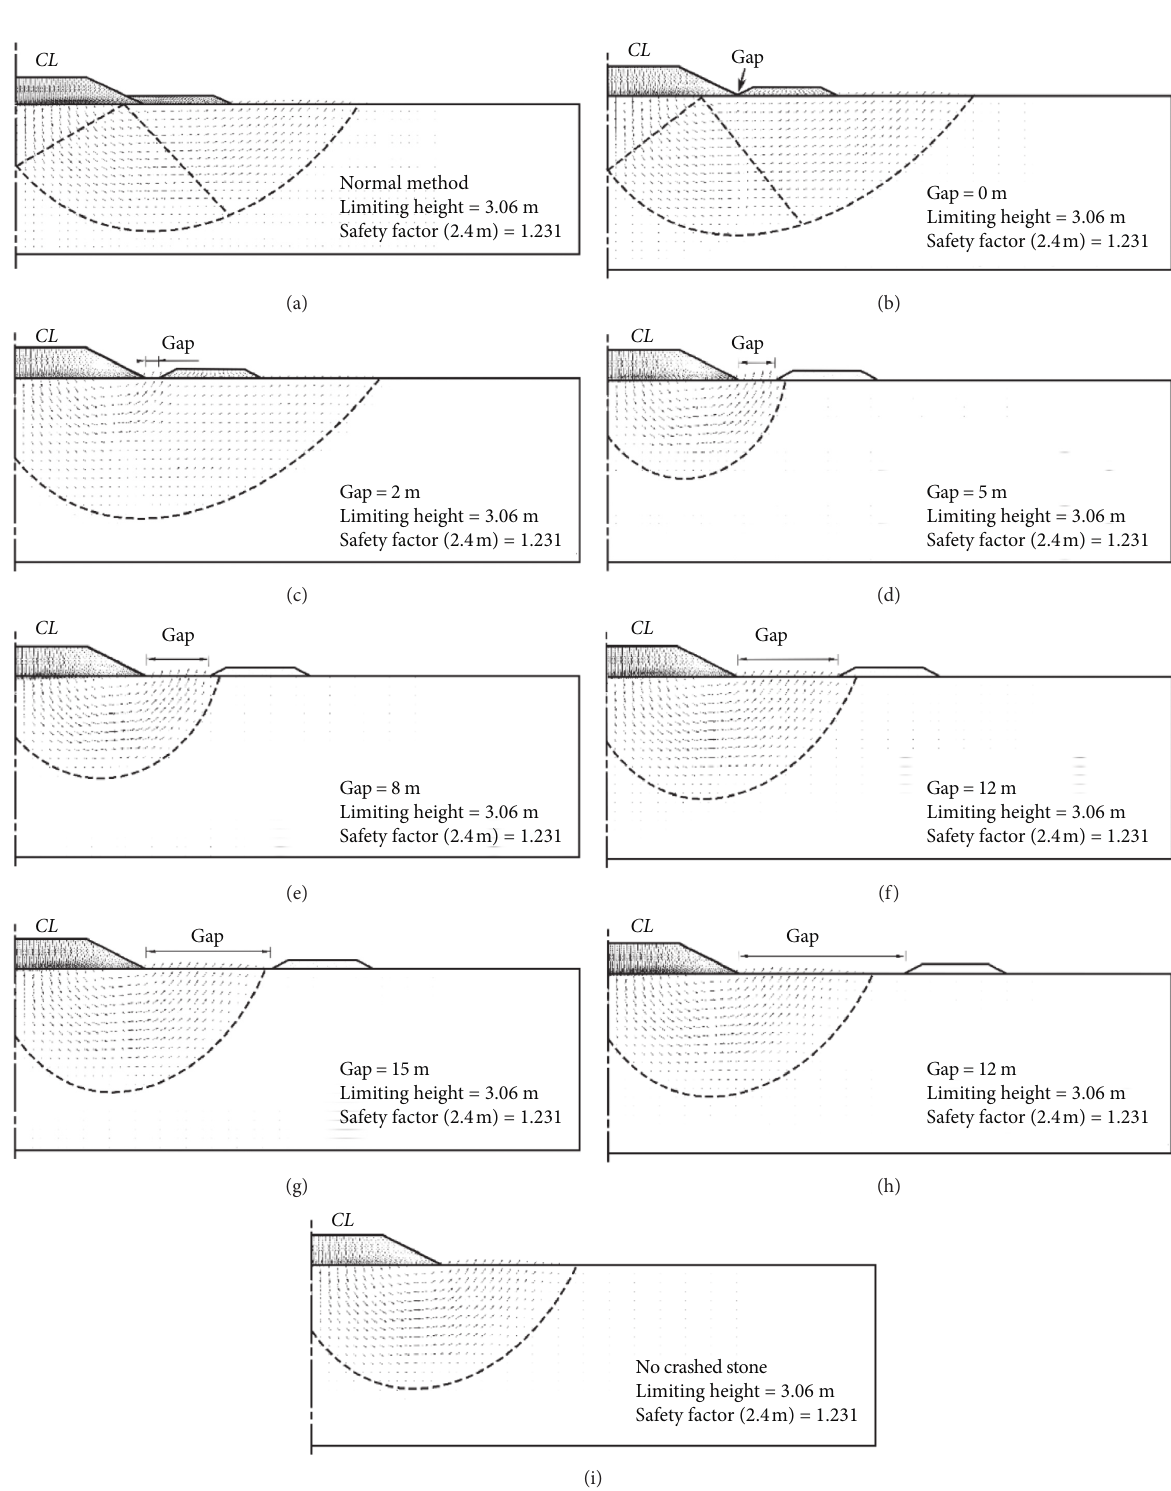
Figure 11: Soil heaving mechanism of large-scale soil bag cofferdams with different distances between berm and cofferdam: (a) with normal crashed stone; (b–h) with different gap; (i) with no crashed